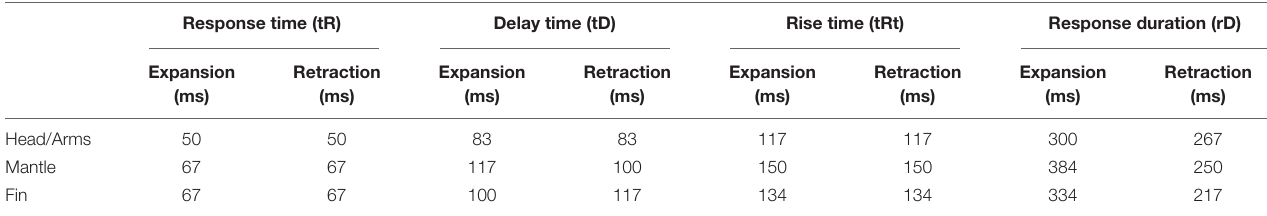
TABLE 1 | Descriptive statistics of temporal dynamics in milliseconds